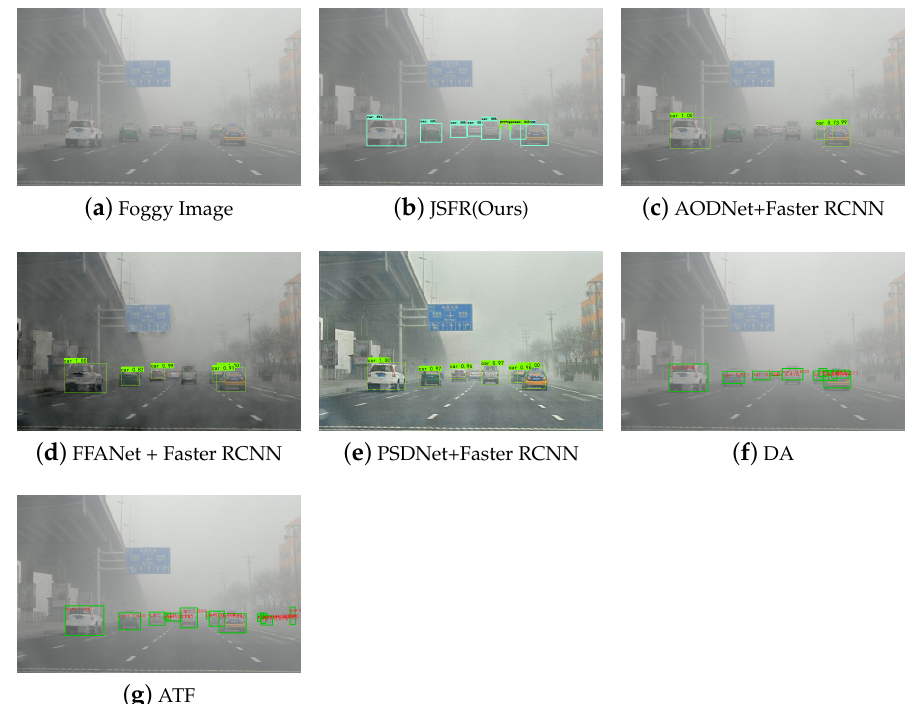
Figure 13. Testing results on RTTS for JSFR , combination methods including AODNet+Faster RCNN , FFANet + Faster RCNN , and PSDNet + Faster RCNN , and domain adaptive methods including DA and ATF (electronic zoom-in